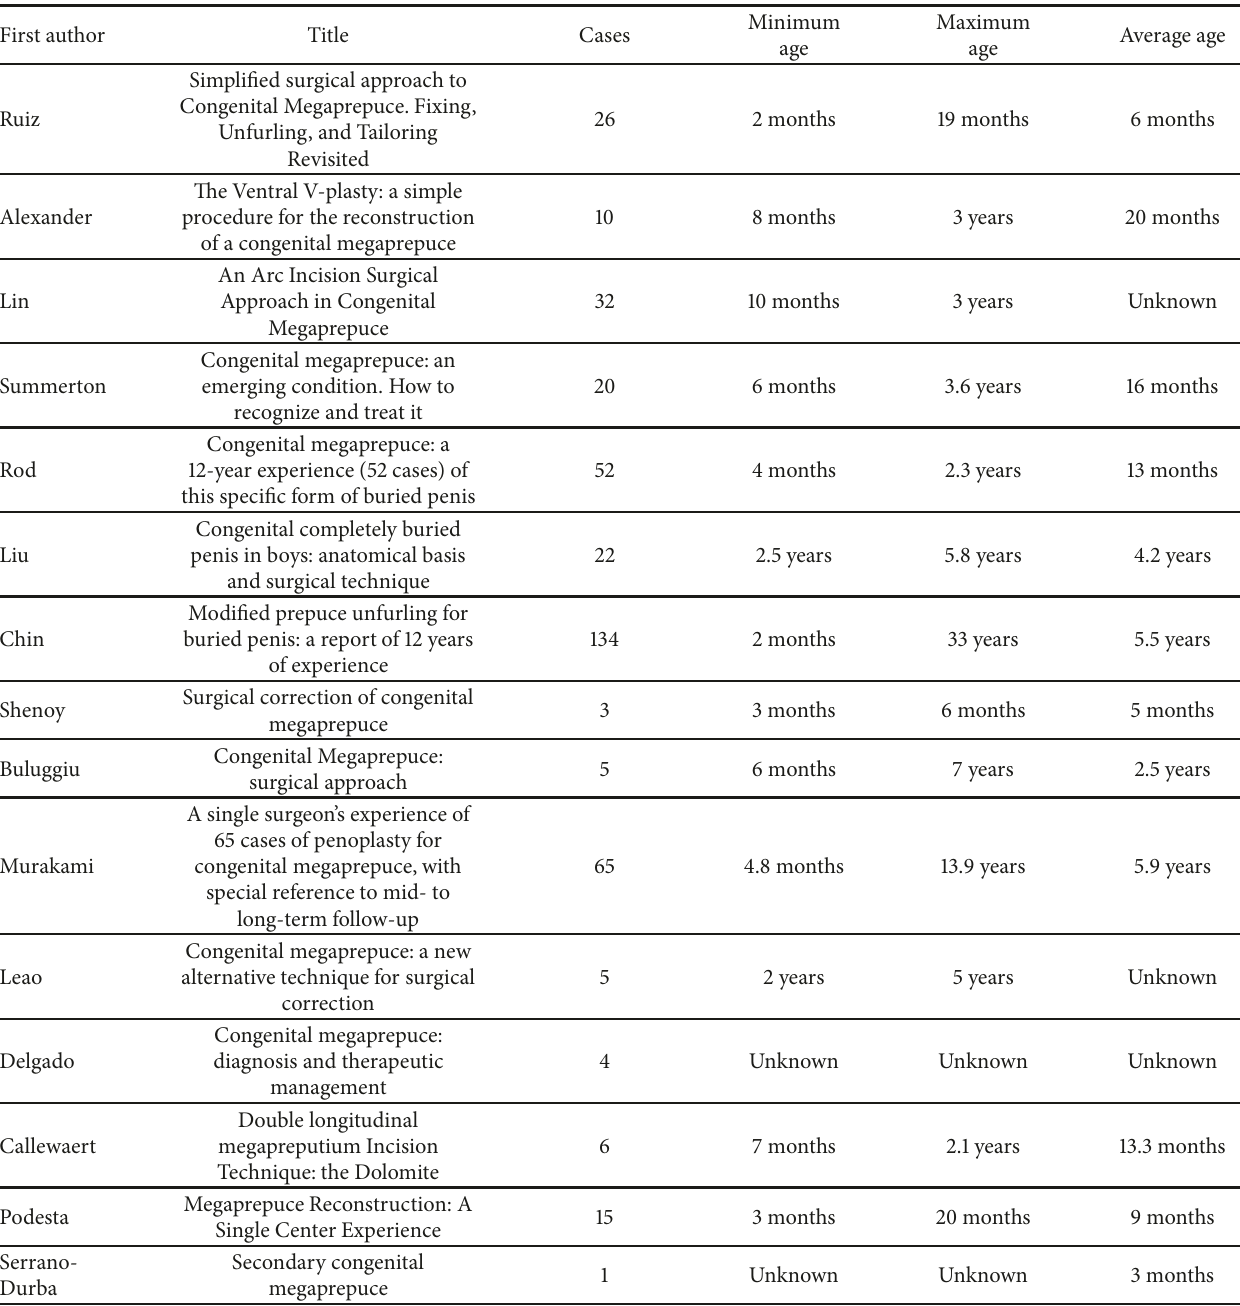
Table 1: Results of congenital megaprepuce literature